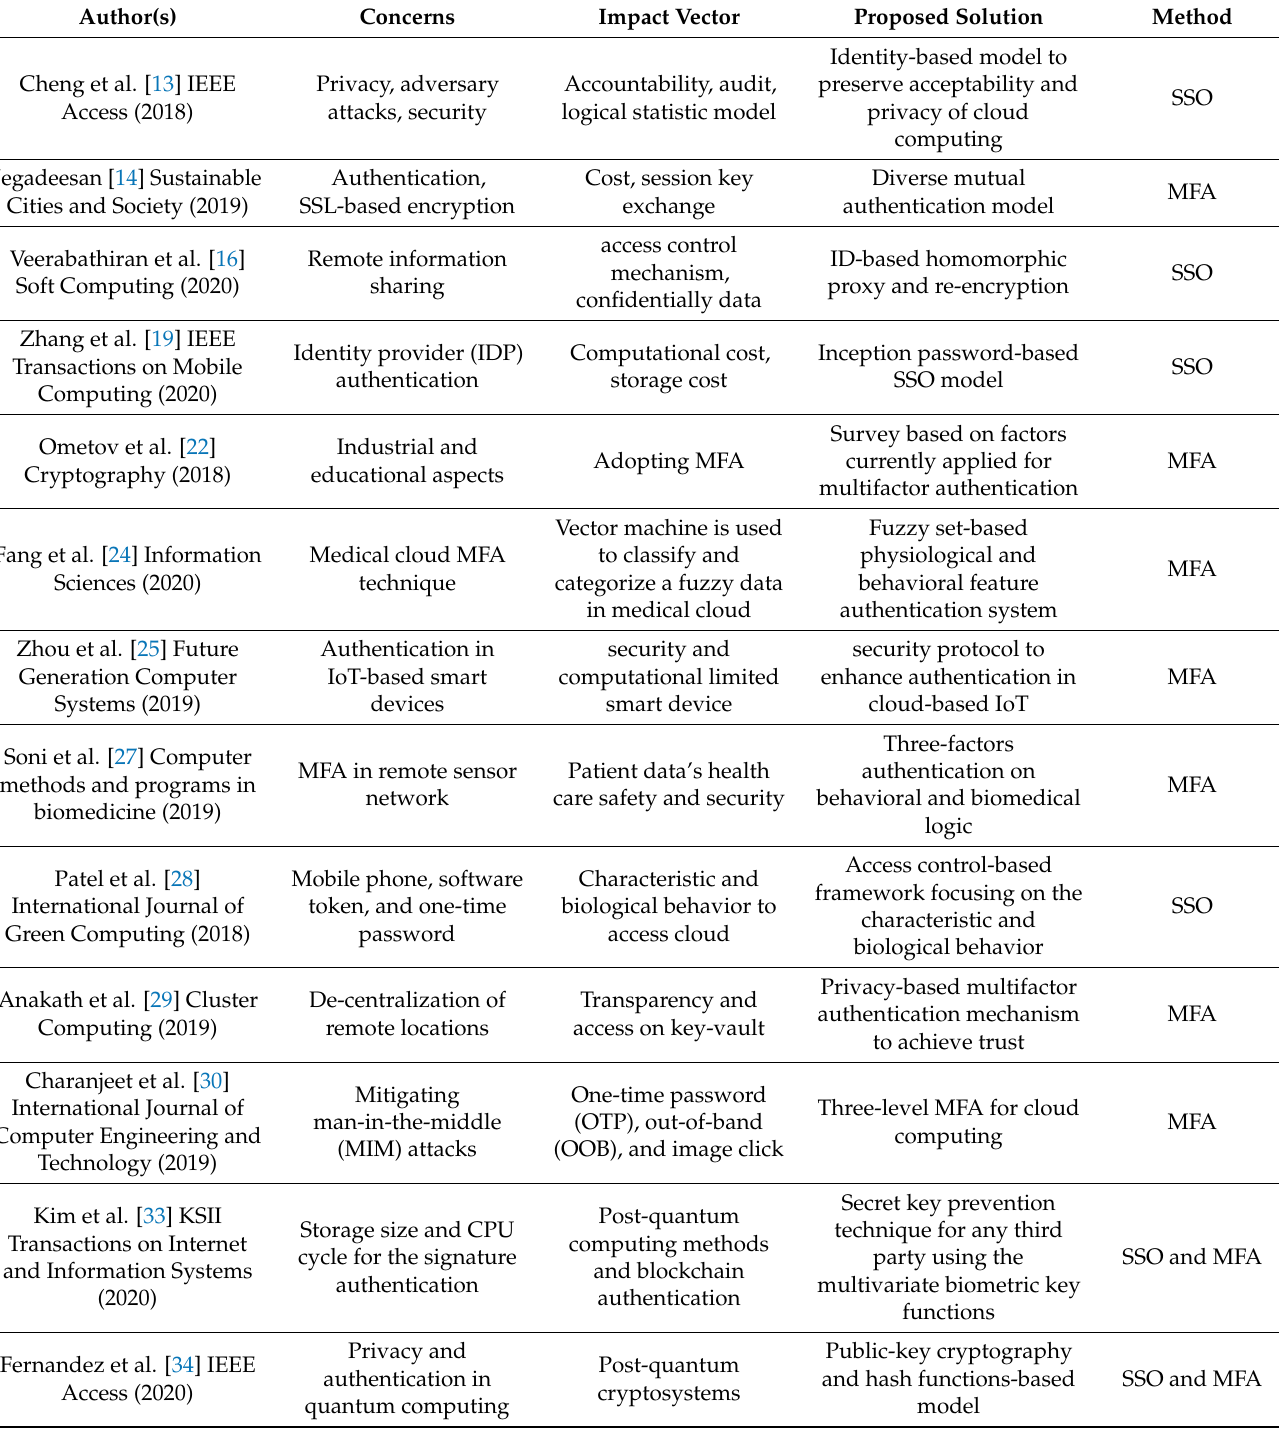
Table 1. Most recent work related to single sign-on (SSO) and multifactor authentication (MFA)